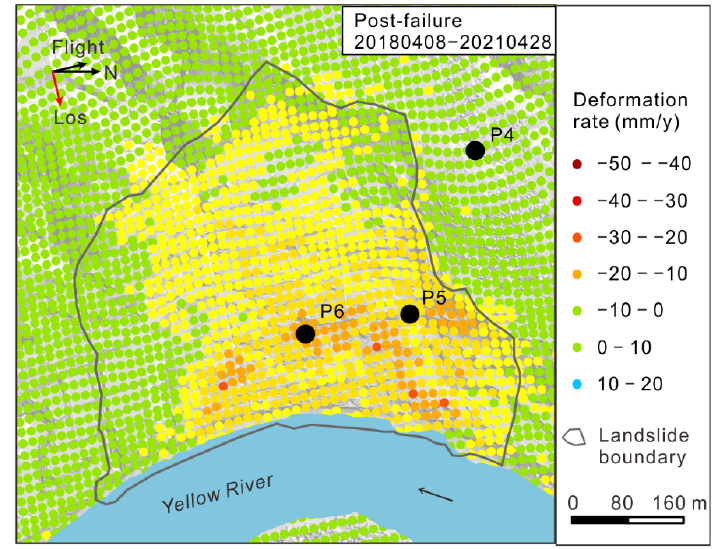
Figure 8. Post-failure mean LOS deformation